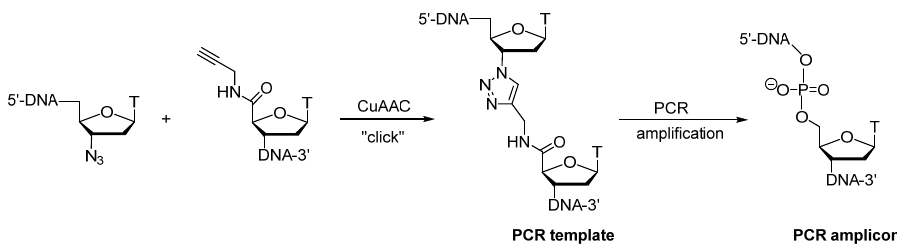
Scheme 9. Synthesis and polymerase chain reaction amplification of DNA strands containing an unnatural triazole linkage.